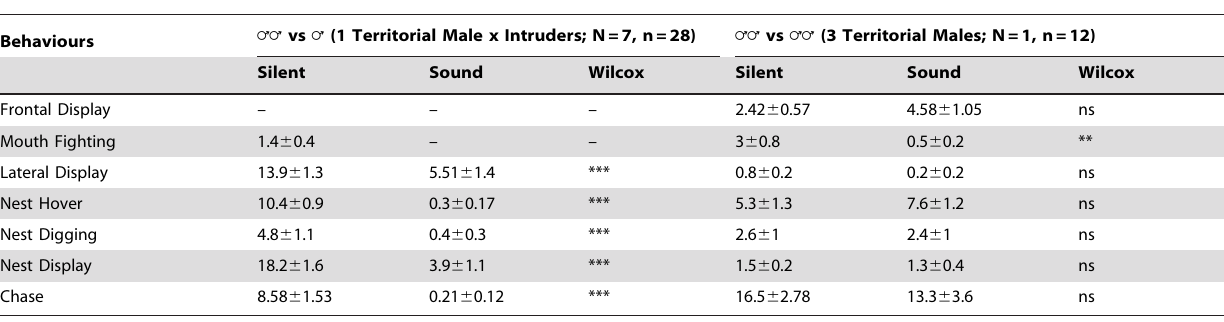
Table 3. Mean 6 SE of the occurrence of a behaviour appearing on a 15 min recording, for Oreochromis niloticus territorial males.